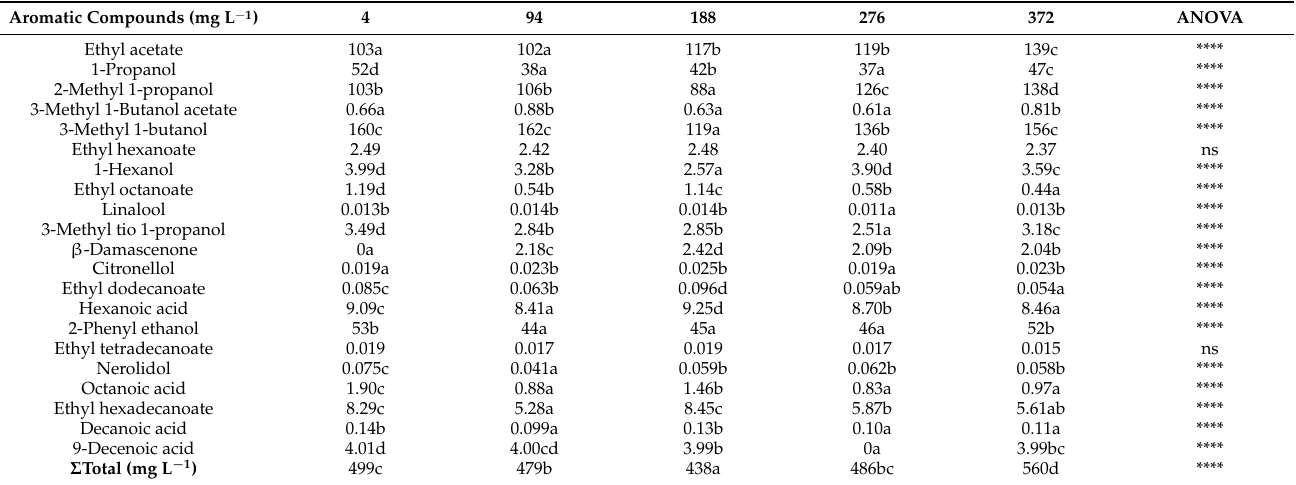
Table 13. Average values of aromatic compounds (concentration and composition) of wines at